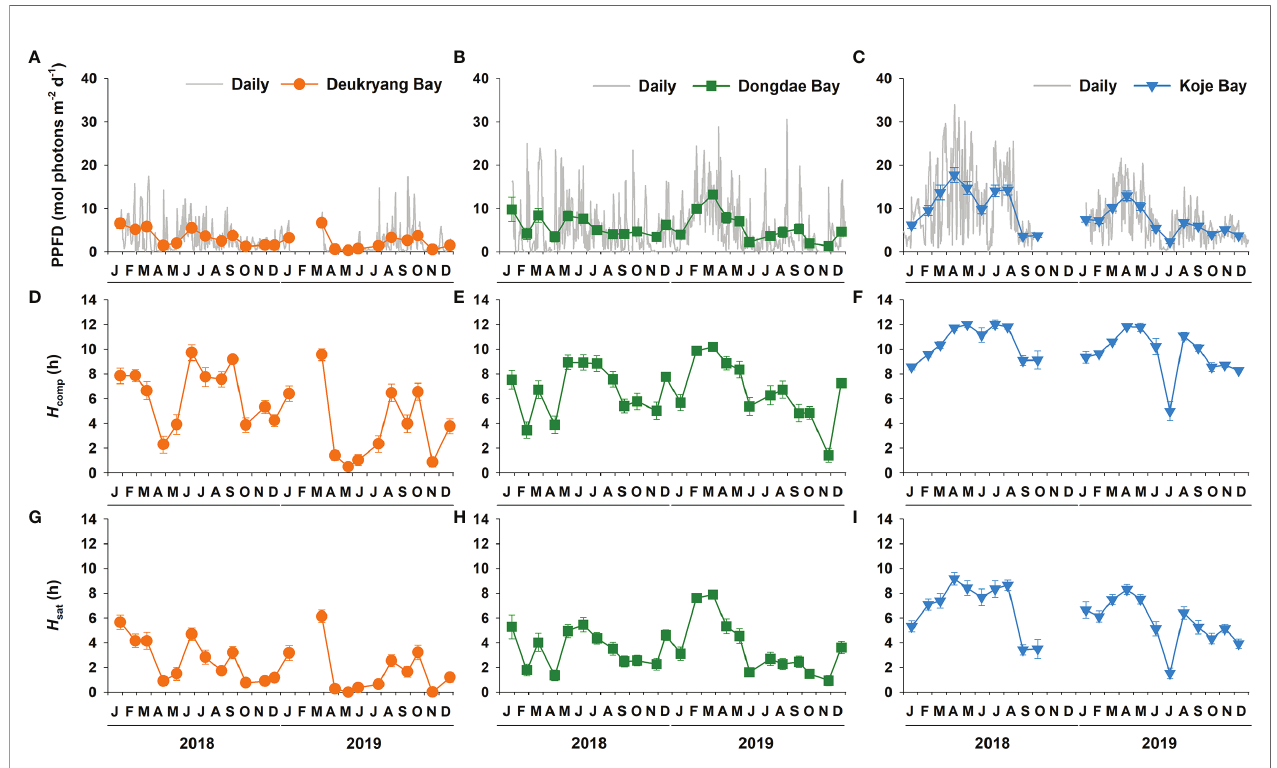
FIGURE 2 | Seasonal variations in underwater photosynthetic photon fl ux density (PPFD; A – C ), daily period of light compensation ( H comp ; D – F ), and daily period of light saturation ( H sat ; G – I ) in Deukryang Bay, Dongdae Bay, and Koje Bay on the southern coast of Korea from January 2018 to December